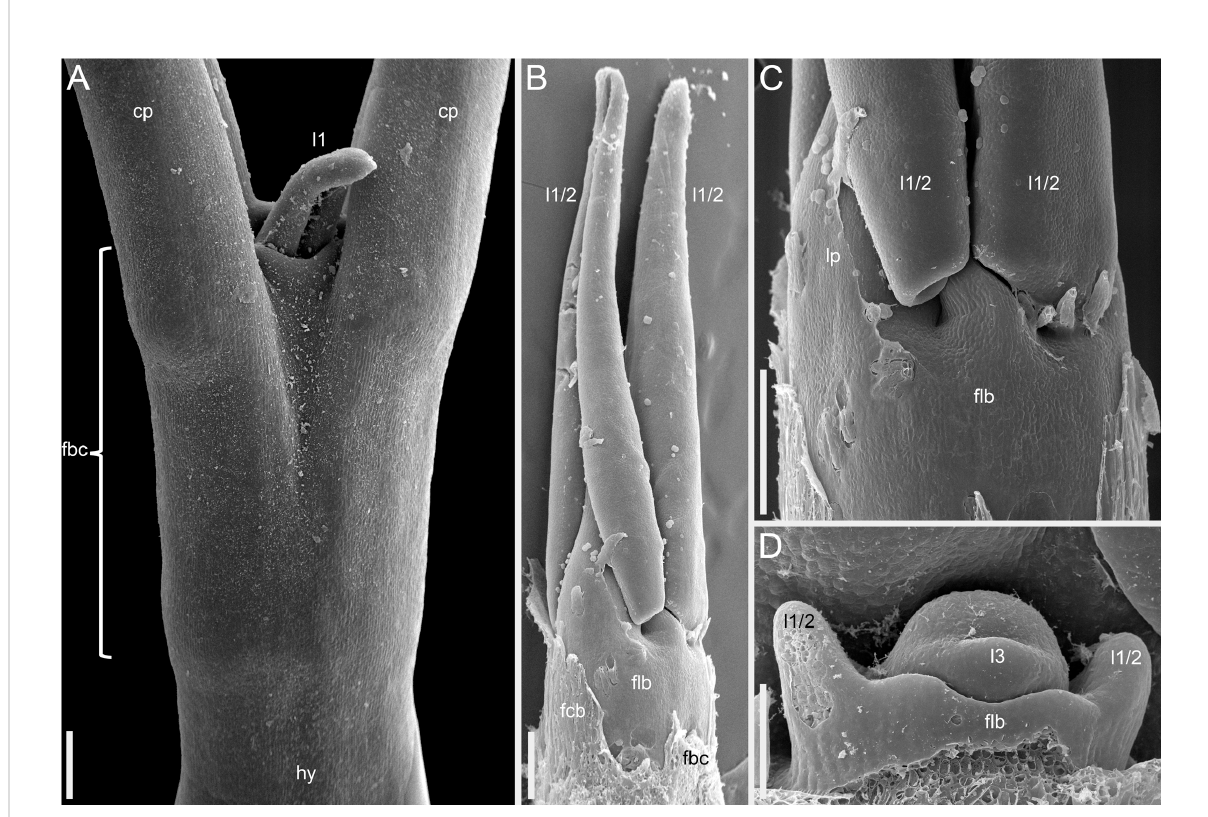
FIGURE 14 Instances of congenital fusion of leaves in Fagopyrum esculentum subsp. esculentum (SEM). (A) cv. Dozhdik. Fused bases of cotyledons. Developmental stage similar to that in Figure 12. (B, C) cv. Temp. An unusual instance of basal fusion between two fi rst leaves of the main axis. (C) is the same sample as (B) viewed from another angle. (D) cv. Temp. An unusual instance of basal fusion between two fi rst leaves of a paracladium. cp, cotyledon petiole; fbc, fused bases of cotyledons (largely removed in B ); fl b, fused leaf bases; hy, hypocotyl; l1, the fi rst leaf above the cotyledons; l1/2, two fi rst leaves above the cotyledons (B, C) or two fi rst leaves of a paracladium (D) ; l3, third leaf; lp, leaf petiole. Scale bars = 300 µm (A – C) , 100 µm (D)